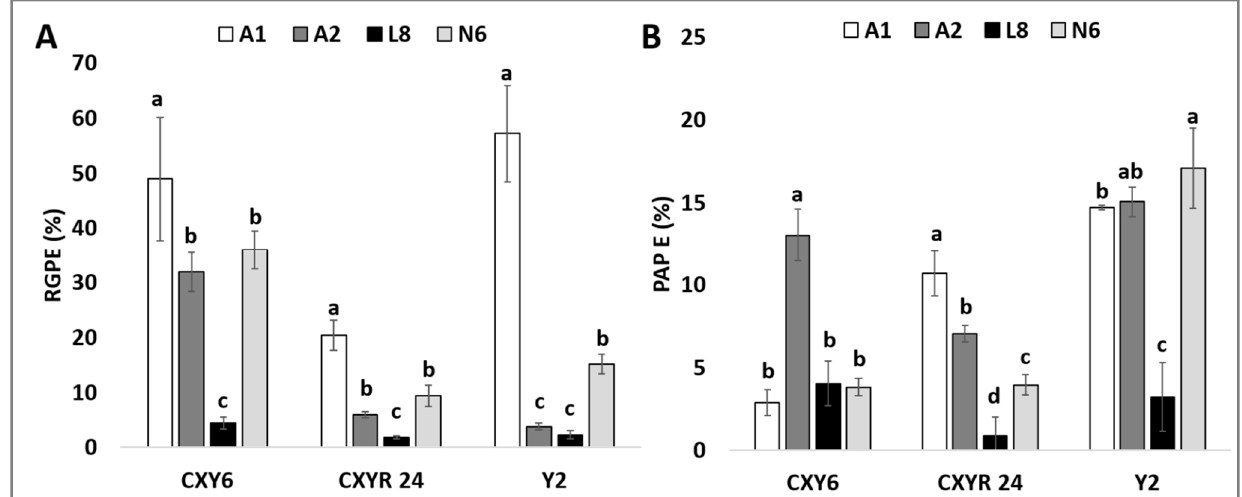
Figure 3. Plant regeneration efficiency of the different hybrids incubated in the test media. ( A ) Comparison of the green plantlet regeneration efficiency (RGPE) of 100 anthers from the hybrids of indica × japonica incubated on the tested media. ( B ) Comparison of the albino plantlet regeneration efficiency (PAPE) of the 100 anthers from the hybrids of indica × japonica incubated on the test media. The data presented are means of five replicates, and error bars represent SD. Values with different letter (a,b,c,d) per genotype are significantly different (Tukey HSD Test, p < 0.05, n = 5 replicates).